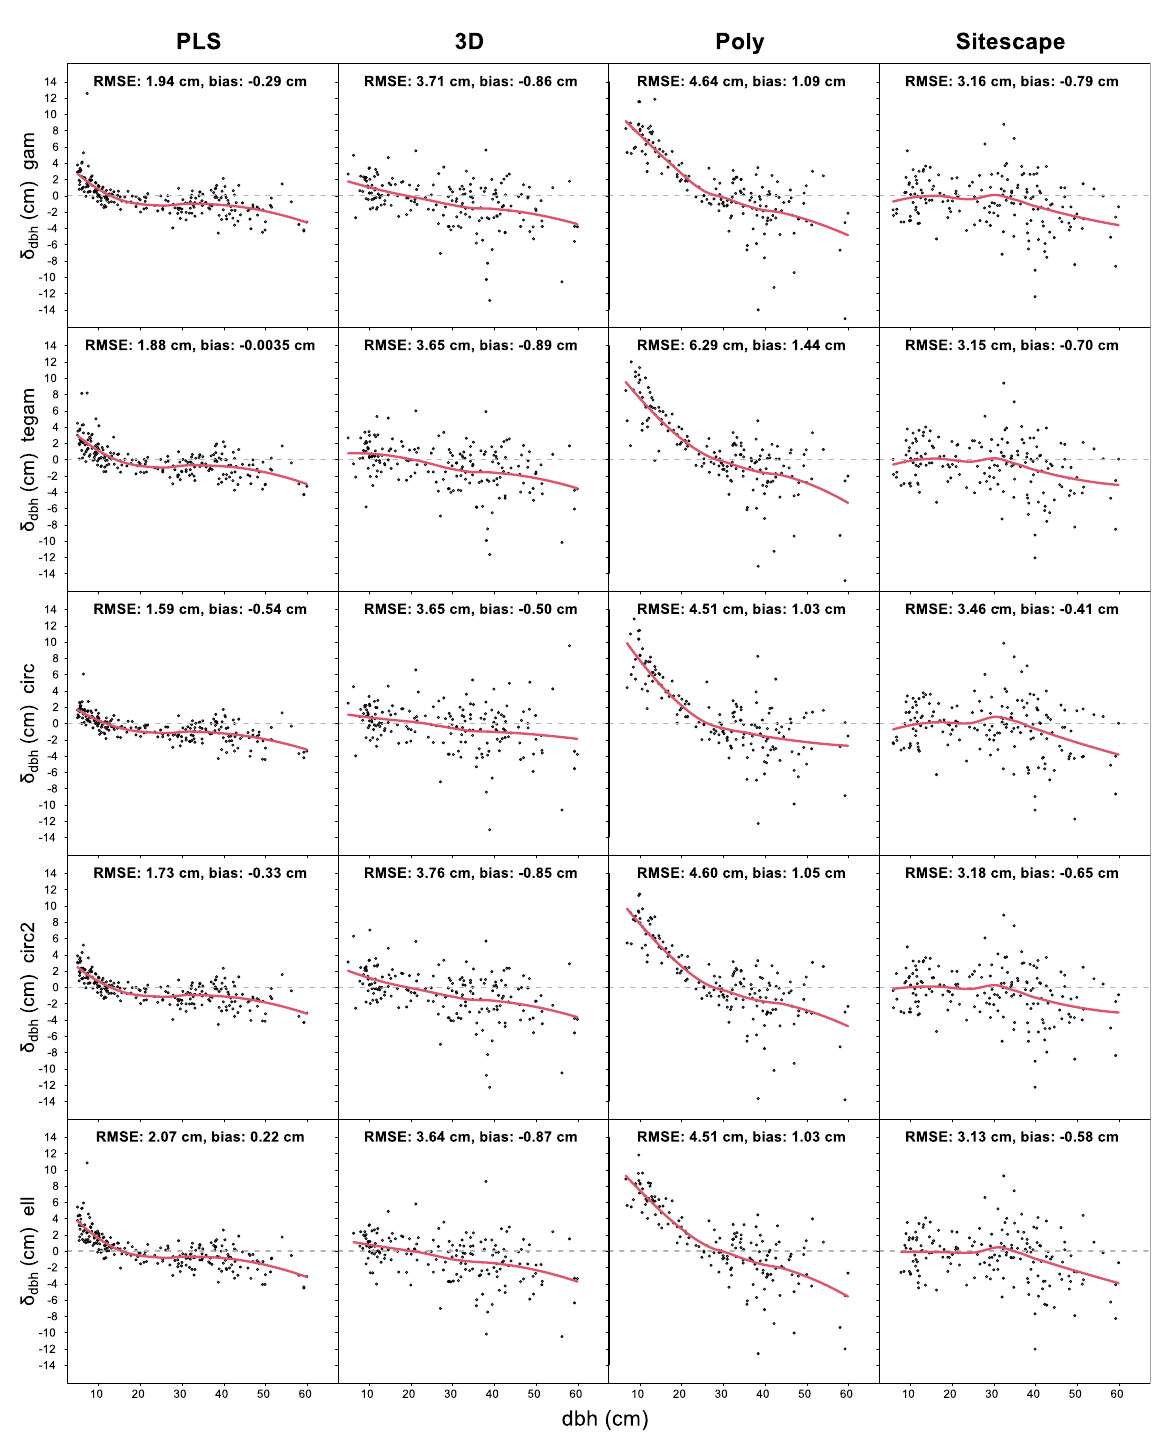
Figure 12. dbh deviation, δ dbh , for different methods of dbh estimation (ell, circ2, circ, tegam, and gam) over 21 sample plots for PLS/iPad. The dashed gray line is zero-reference. The solid red line is a locally weighted scatterplot smoothing (LOESS) fit with a span of ¾ .